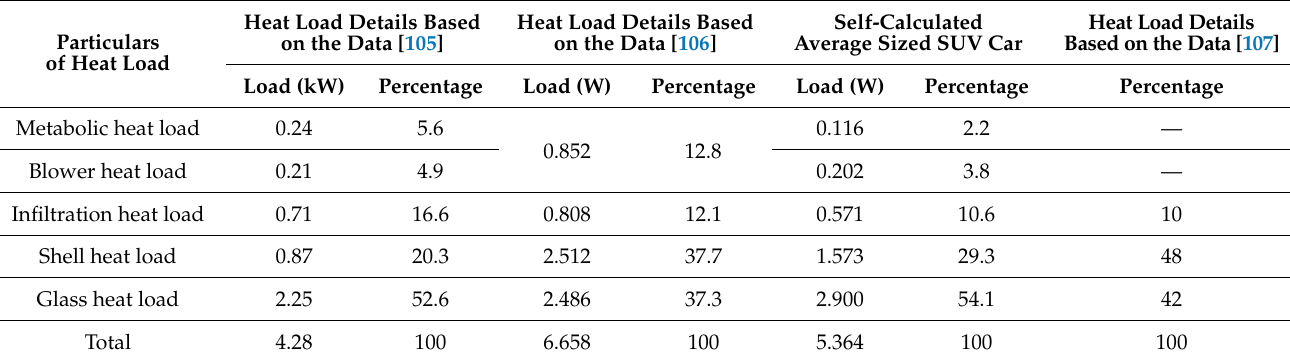
Table 7. Heat penetration through the different cabin